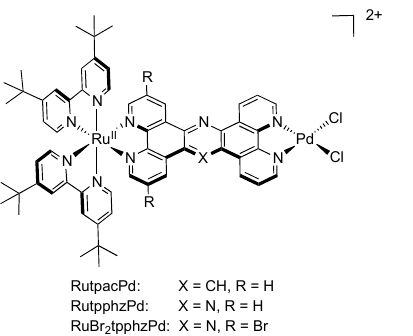
Figure 50. Ruthenium II complex with various extended π -systems.